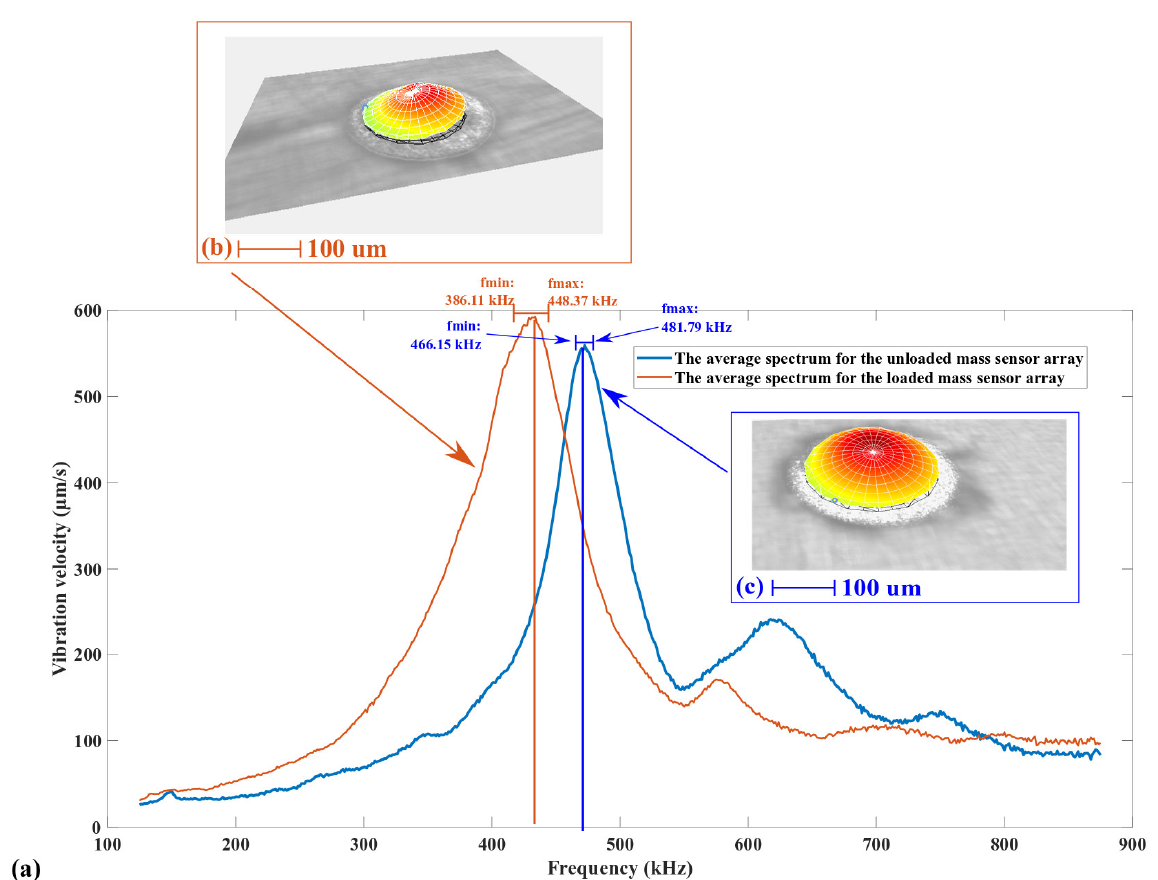
Figure 13. Mass sensor average performance test result. ( a ) The average spectrums for the mechanical resonance of 50 piezoelectric MEMS mass sensors, with and without the load. ( b ) The representative modal shape for the fundamental resonant mode of 50 MEMS mass sensors with mass load, and ( c ) the representative modal shape for the fundamental resonant mode of 50 MEMS mass sensors without mass load. Table 5. Statistics of the mechanical resonance measurement of the mass sensor arrays.